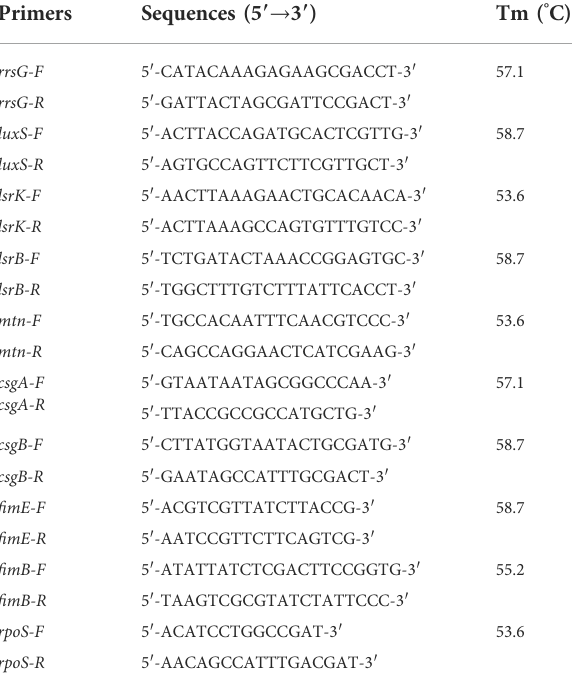
TABLE 1 PCR primers of Escherichia coli for analysis of gene expression.